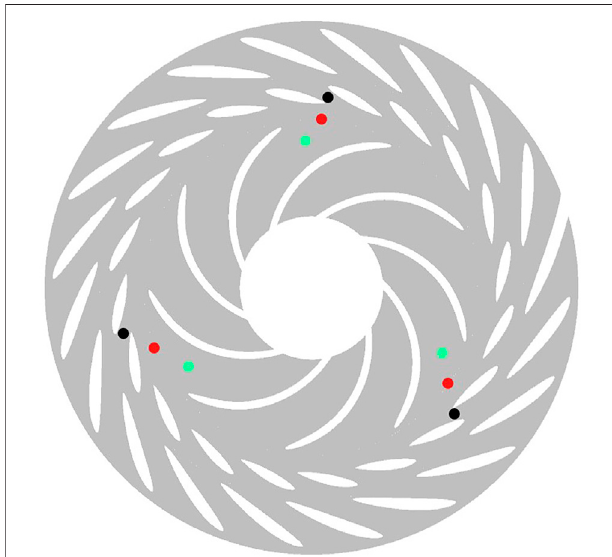
FIGURE 7 | Entropy production rate distribution. FIGURE 8 | Monitoring point setting.